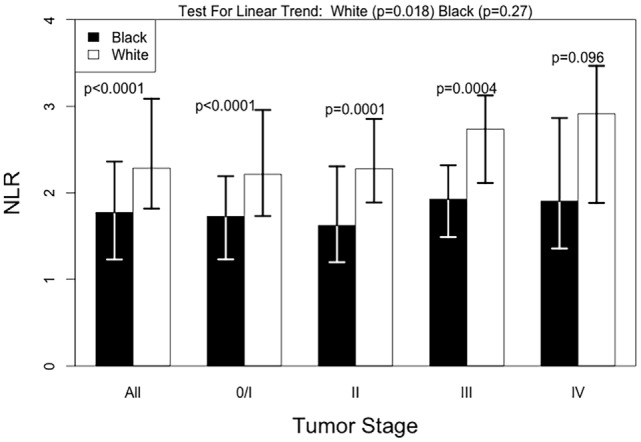
Median NLR levels by tumor stage, according to race. Test for linear trend was done with univariate linear regression and tests by stage were done using the Mann–Whitney test.